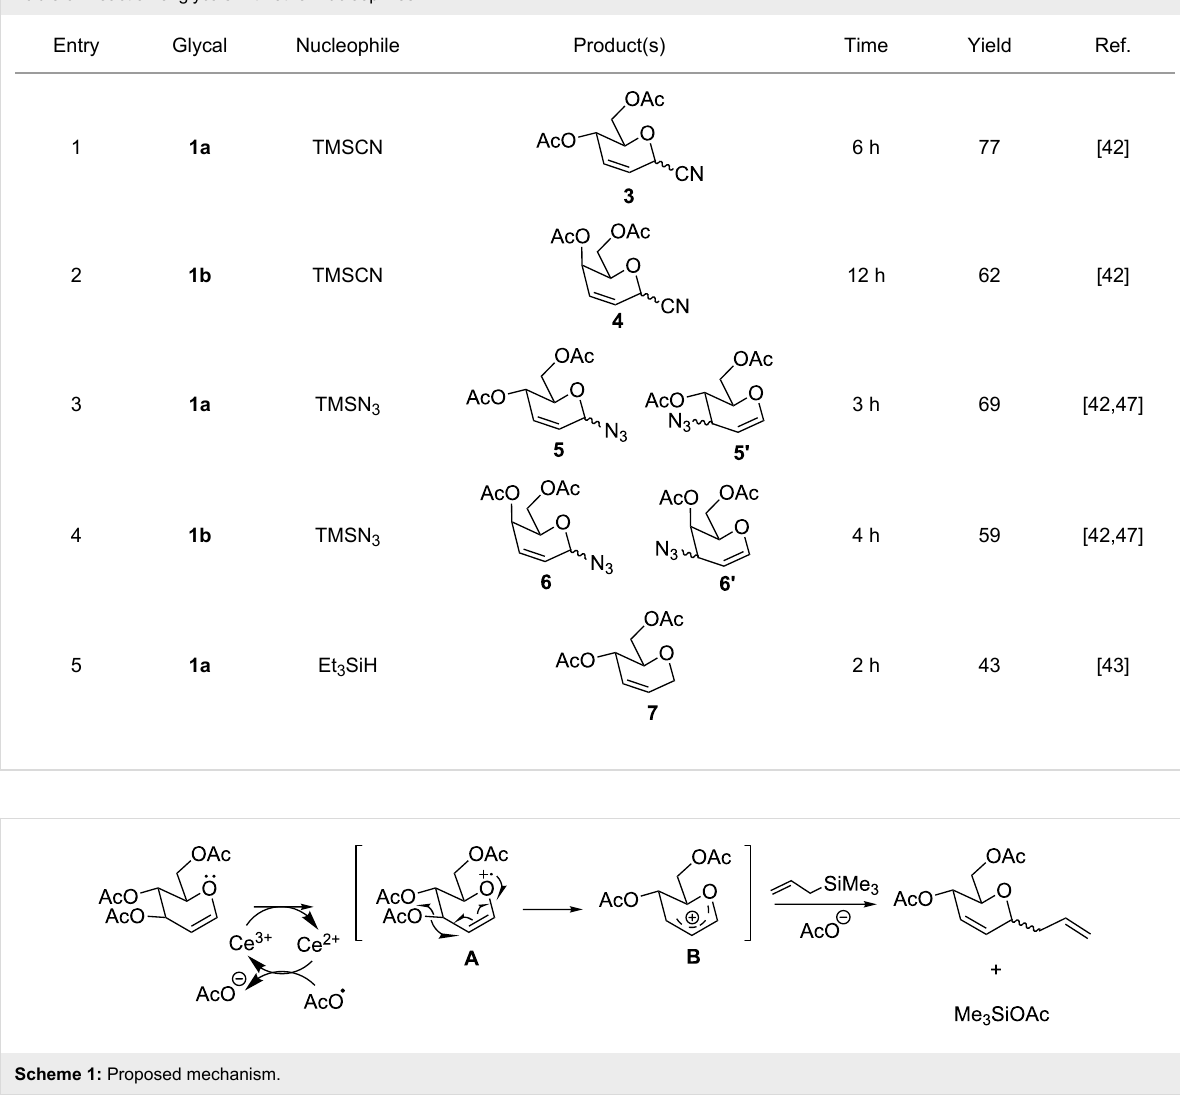
Table 3: Reaction of glycals with other